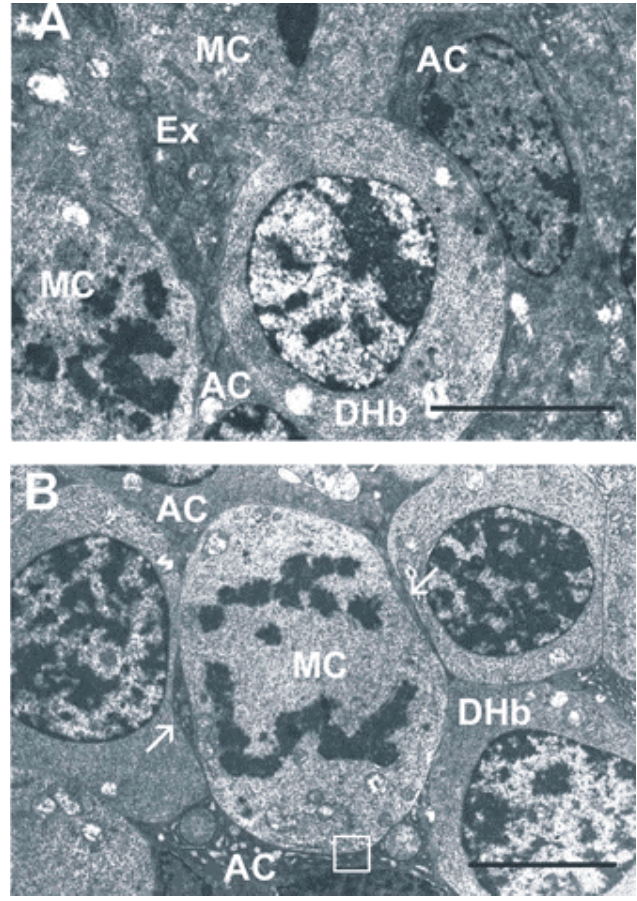
FIGURE 3. Peculiarities of ultrastructural changes of hepatoblasts in fetal liver of rat embryos of different ages at the early stage of apoptosis (continuation). (A) Soma and the excrescences (Ex) of apoptotic cells (AC) adjoining mitotic cells (MC) and differentiating hepatoblast (DHb). ED19. (B) Fragments of apoptotic cells at poles of mitotic cell; thin excrescences (arrows) penetrating between mitotic and differentiating hepatoblasts. ED19. (C) Fragment of excrescence of apoptotic cell that can be considered as apoptotic body (AB) in the space between the differentiating hepatoblast and telophase cell (TPh). ED19. (D*) Disruption of integrity of plasma membranes between apoptotic (AC) and adjoining cells (Fig. 2C frame on the right). (D**) Formed and forming micropinocytic vesicles (white arrows) and vesicles (black arrows) between apoptotic (AC) and adjacent calls (Fig. 2C, frame in the center). (D***) Contacts between the cells are presented as three dense staining layers alternating with two light ones (frame in Fig. 3B). (E) Irregular cell with polymorphic cytoplasmic excrescences is characterized by significant expansion of perinuclear space (PnS) and cisterns of RER (arrow). ED19. (F) Decrease of apoptotic cell in size resulted by reduction of cytoplasmic excrescences; in irregular nucleus a large nucleolus is seen. ED19. Scale bars A, B, C, E, and F, 5 μ m; D*, 0.1 μ m; D** and D***, 0.2 μ